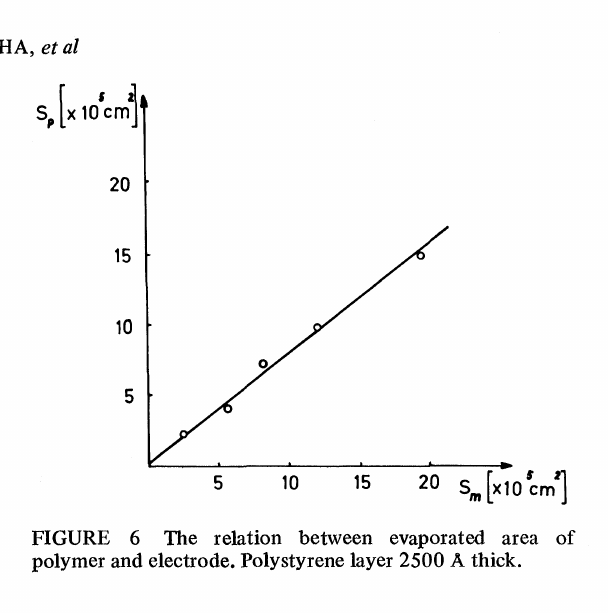
FIGURE 6 The relation between evaporated area of polymer and electrode. Polystyrene layer 2500 A thick.